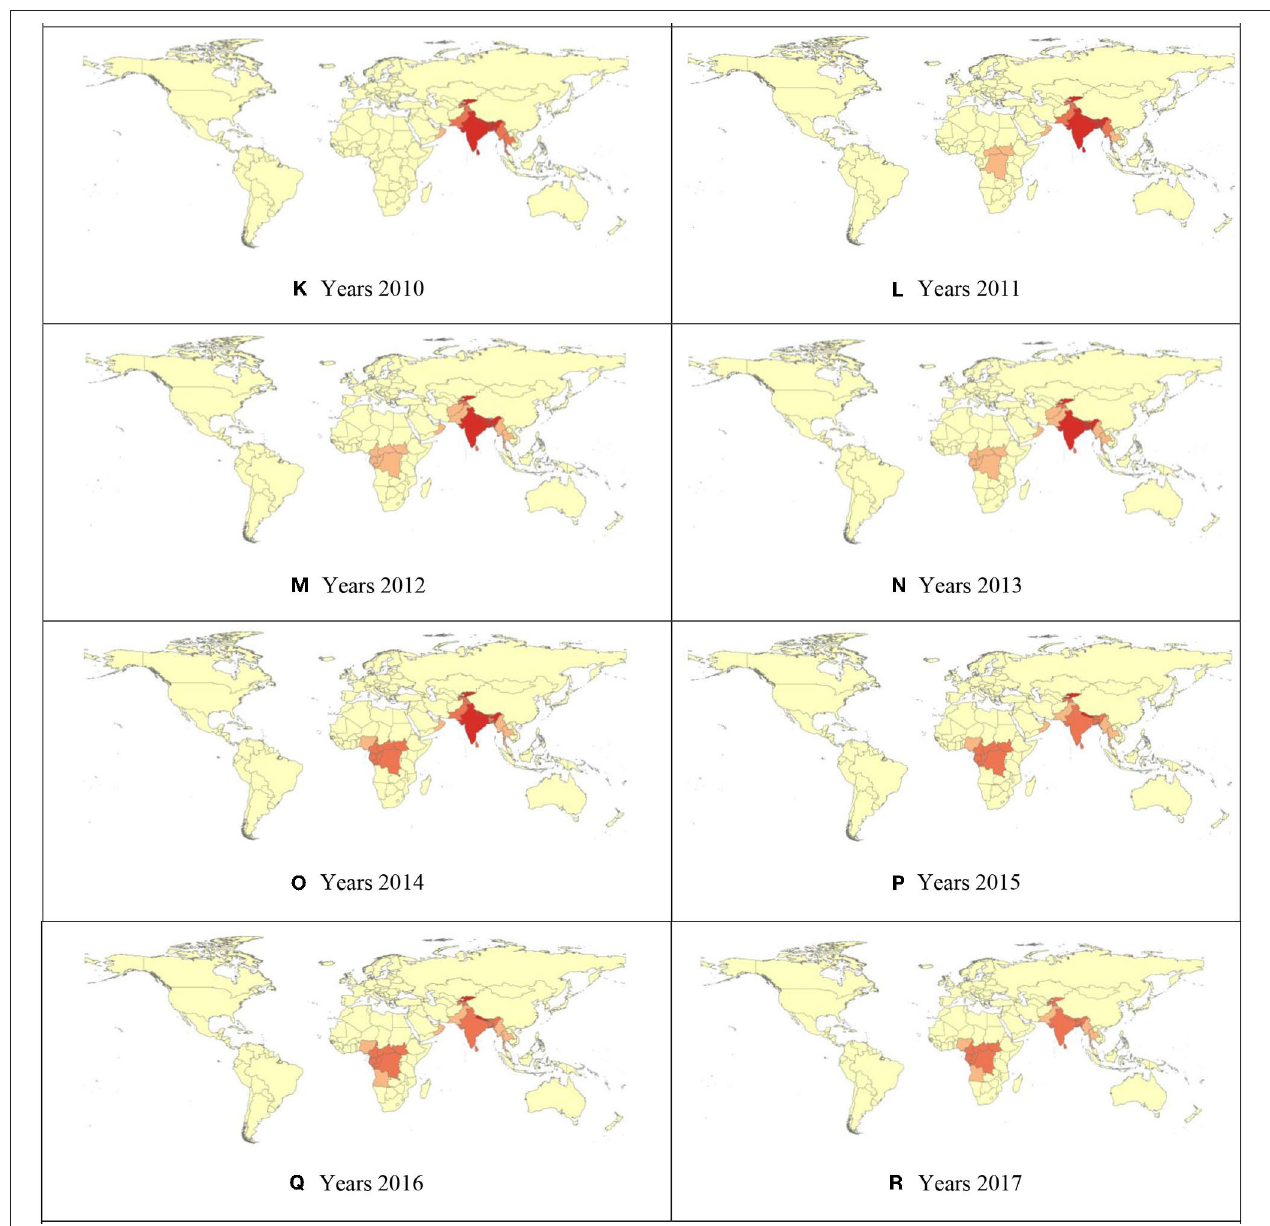
FIGURE 1 | (A–R) Hot Spot Analysis (Getis-Ord Gi*) of Child Mortality due to diarrheal diseases